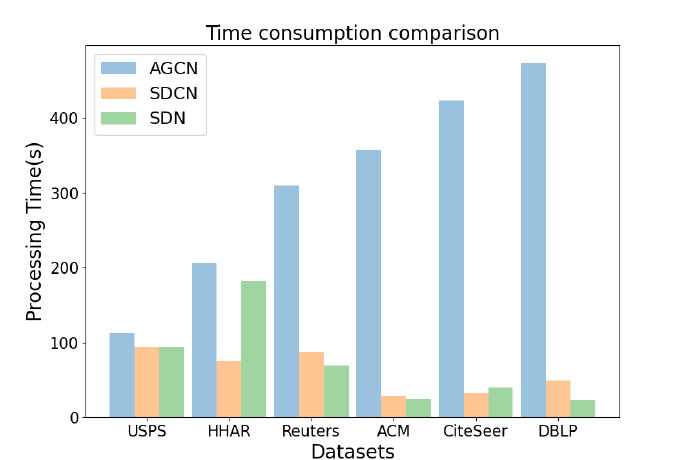
Figure 2. Time consumption comparison chart of AGCN, SDCN, and SDN on six datasets. The experiments are conducted on a machine with Intel(R) Xeon(R) Gold 6130 CPU @ 2.10GHz, and a single NVIDIA GeForce RTX 2080 Ti with 11GB memory. The operating system of the machine is Ubuntu 18.04.5 LTS. As for software versions, we use Python 3.9.12, Pytorch 1.11.0 and CUDA